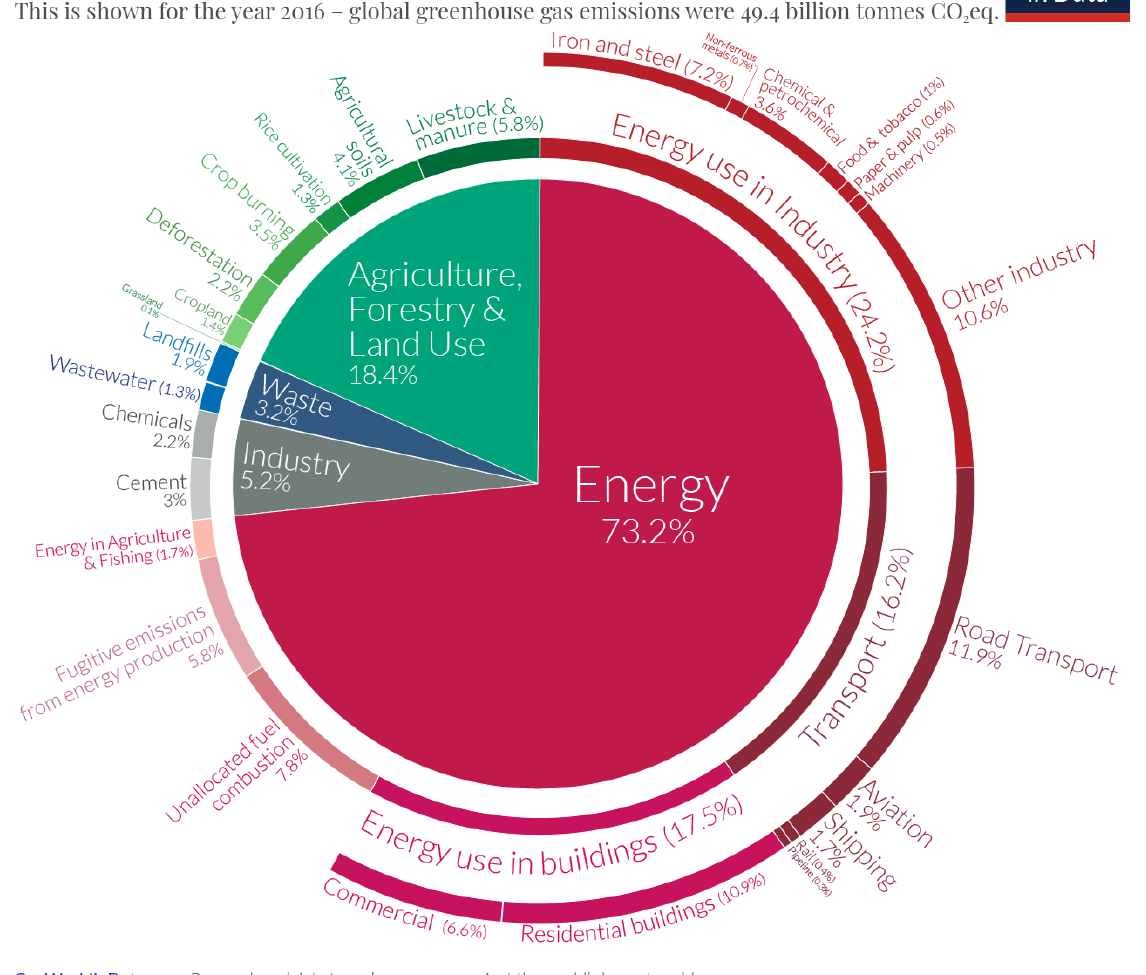
Figure 2. Global greenhouse gas emissions by sector in 2016 according to Ritchie